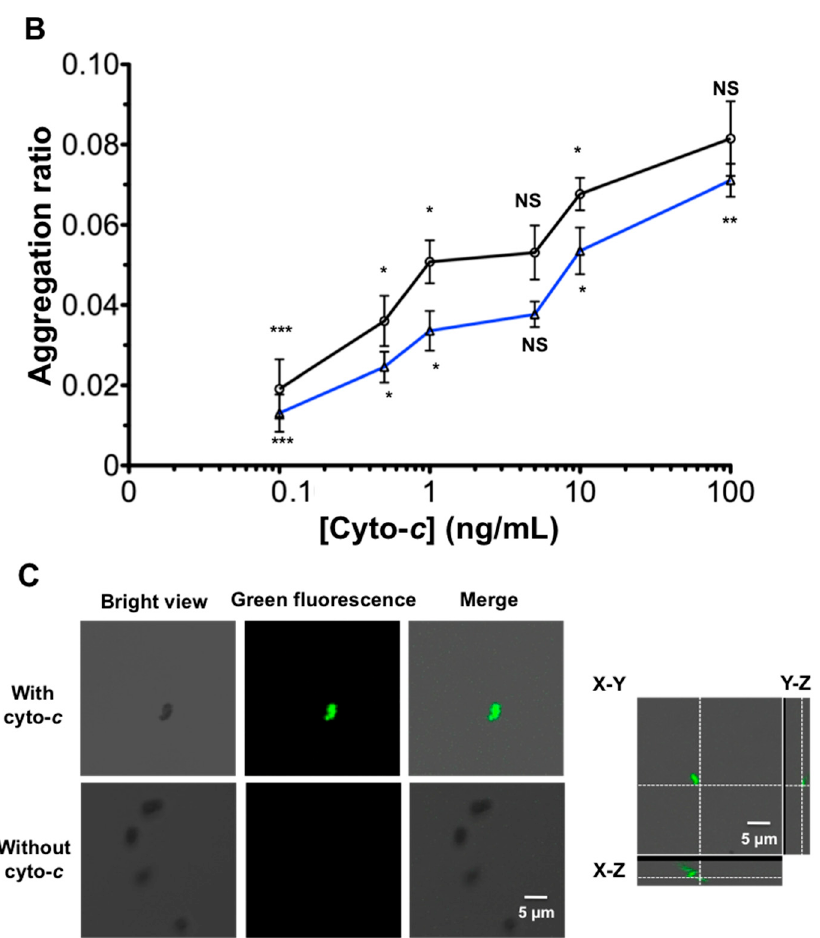
Figure 4. Sensitivity of cyto- c sensing. Cyto-c solutions of known concentrations (0, 0.1, 1, 10, 100 ng/mL) were used for AuNR-LSPR sensing. The absorbance spectrum ( A ) and the standard curve of the LSPR signal verse cyto- c concentrations were plotted ( B ). Results are mean ± SEM ( n = 3), not significant (NS) p > 0.05, * p < 0.05, ** p < 0.01, *** p < 0.001. Confocal microscopy images showed the investigation